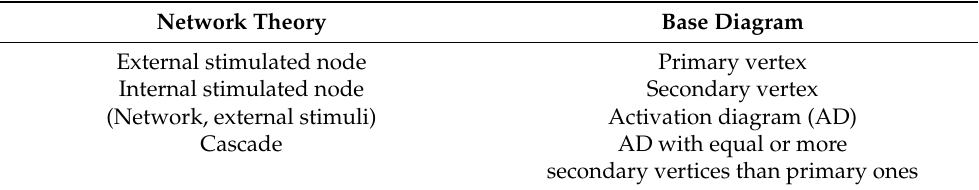
Table 1. Equivalent definitions between networks and base diagrams.